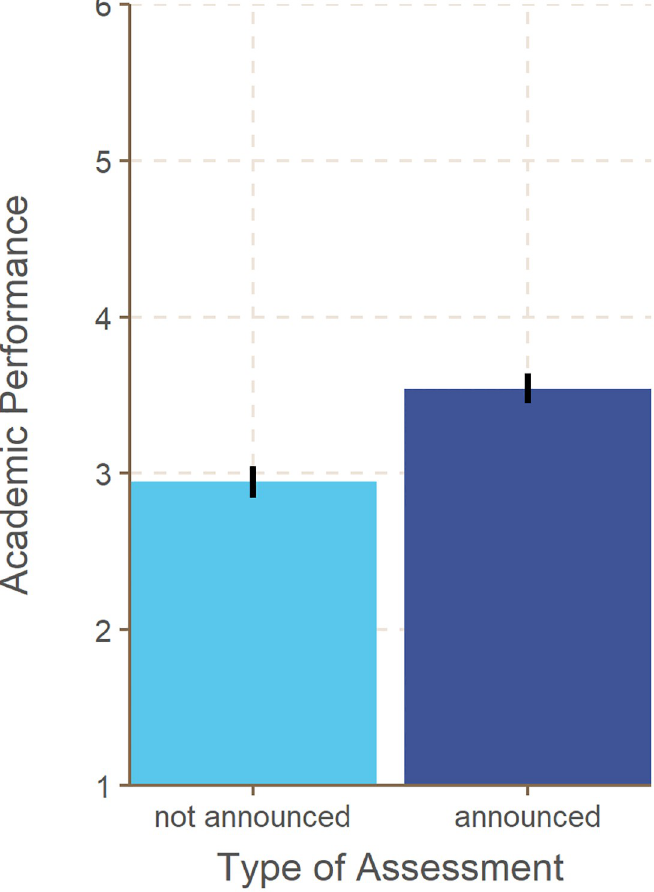
Fig 2. Academic performance as a function of the type of assessment. Error bars represent 95% confidence intervals. Academic performance reflects inverted grades such that higher values correspond to better performance.